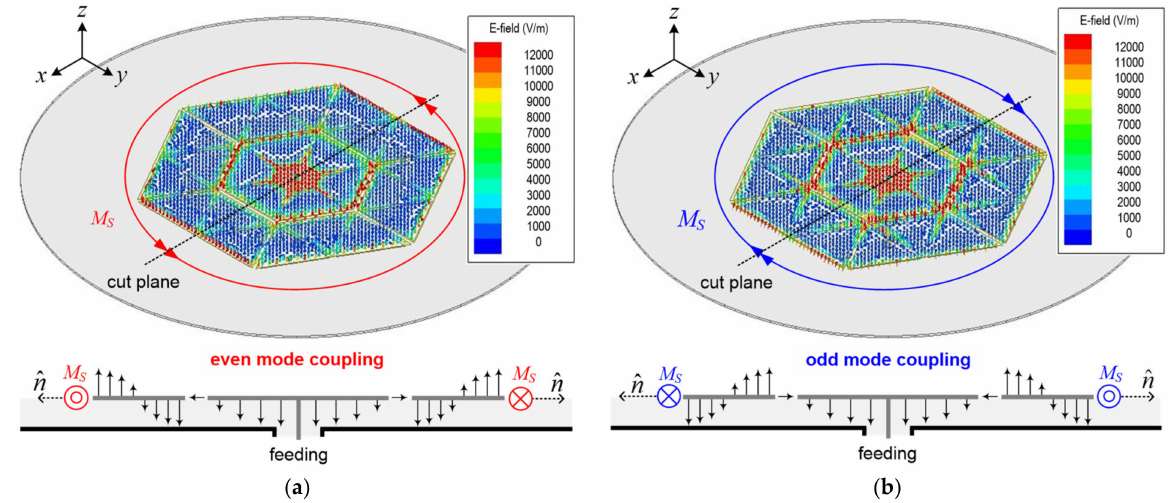
Figure 3. Design concept with simulated electric-field distributions at TM 02 modes and their electric-field vector magnitudes in cut plane: ( a ) even TM 02 mode of lower resonant frequency of 5.264 GHz and ( b ) odd TM 02 mode of higher resonant frequency of 5.897